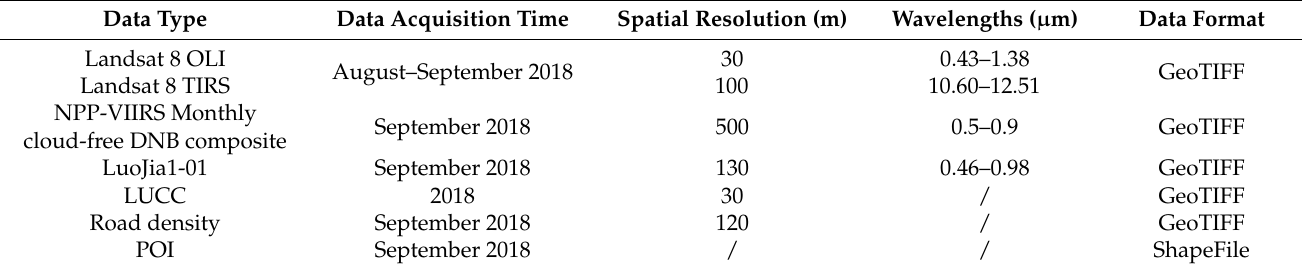
Table 2. Attributes of data used in this